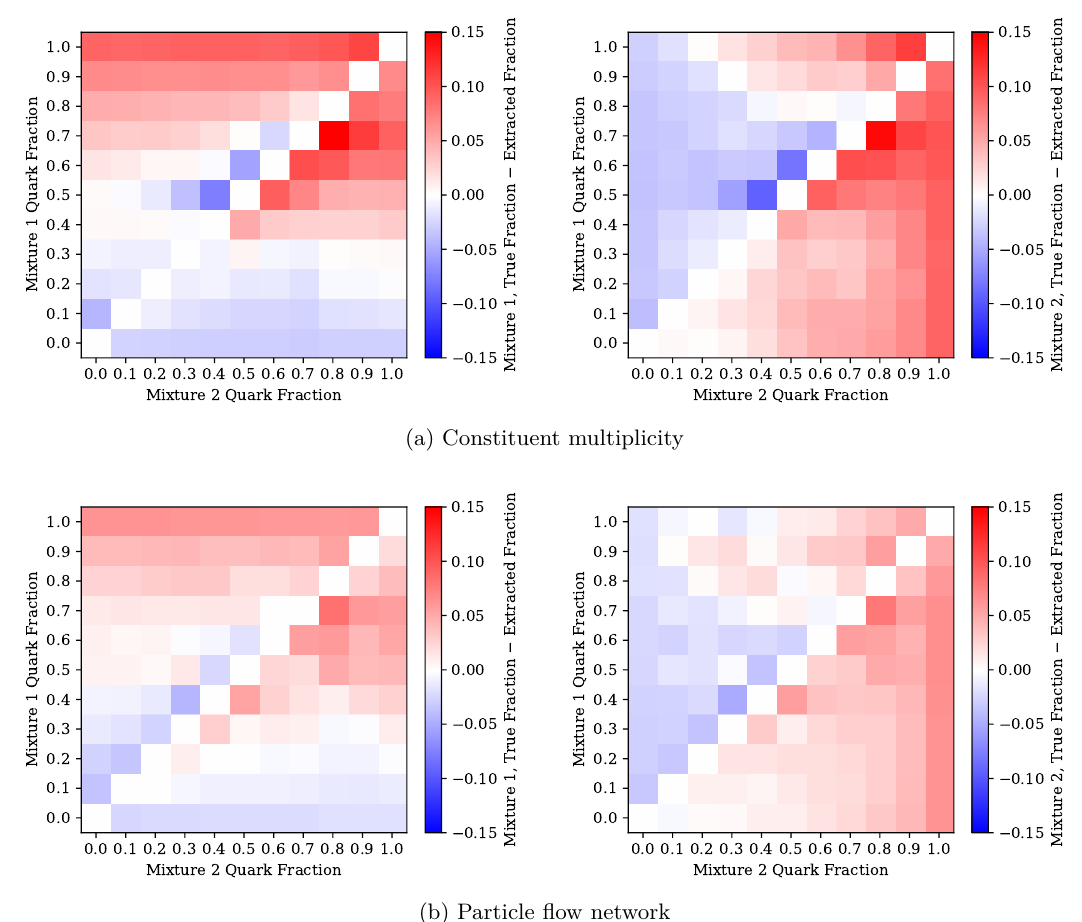
Figure 7 . The difference between the extracted and true quark fractions of (left column) mixture 1 and (right column) mixture 2 for different quark fraction values between zero and one. The (top row) jet constituent multiplicity or (bottom row) the output of a particle-flow network trained to discriminate quark and gluon jets was used to construct the topics used for the extraction of the quark fractions. The anchor regions used for the topics extractions as a function of this 2D plane are optimised for two mixed samples that are 50% and 80% quark jets, but could be reoptimized for each bin of the distribution in order to improve the closure for a specific set of mixtures. The extracted fractions via PFN tend to exhibit smaller non-closure than those extracted using the particle